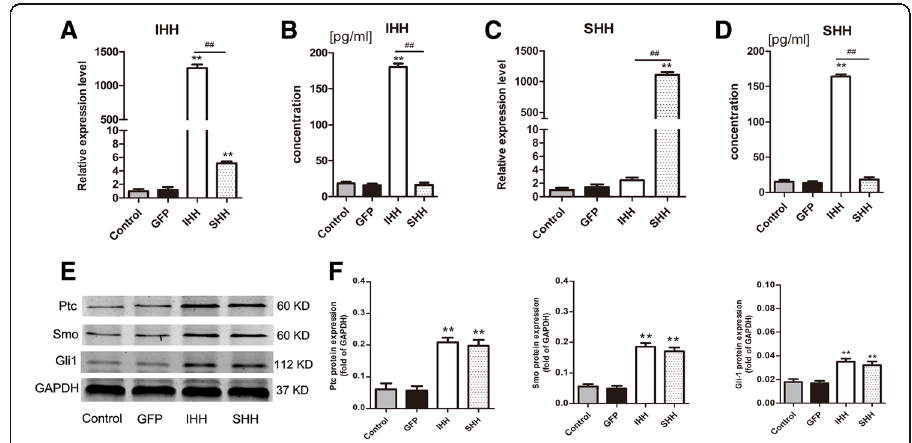
Fig. 2 Expression levels of Hedgehog proteins and Hedgehog signaling molecules. ( a and c ) qRT-PCR was used to demonstrate mRNA expression levels of IHH and SHH following viral transfection; values are means ± SD ( n = 3). The results were normalized to B2M mRNA expression. ( b and d ) ELISA was used to demonstrate IHH and SHH expression levels following viral transfection. Values are means ± SD ( n = 5). ( e ) The hedgehog signaling molecules Ptc, Smo and Gli1 were detected by western blotting after viral transfection for 72 h. ( f ) The results were normalized to GAPDH protein expression. Values are means ± SD ( n = 3). Significant differences between the control group (non-transfection cells) are indicated by * p <0.05 or ** p <0.01; differences between IHH and SHH transfection groups are indicated by # p <0.05 or ## p